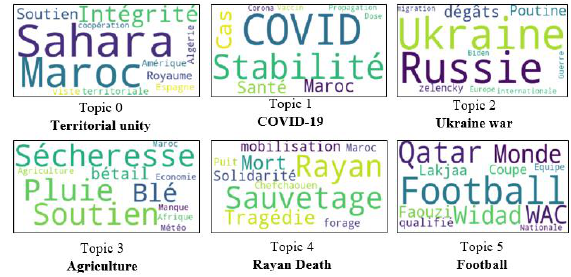
Figure 6. The extracted topics from the French